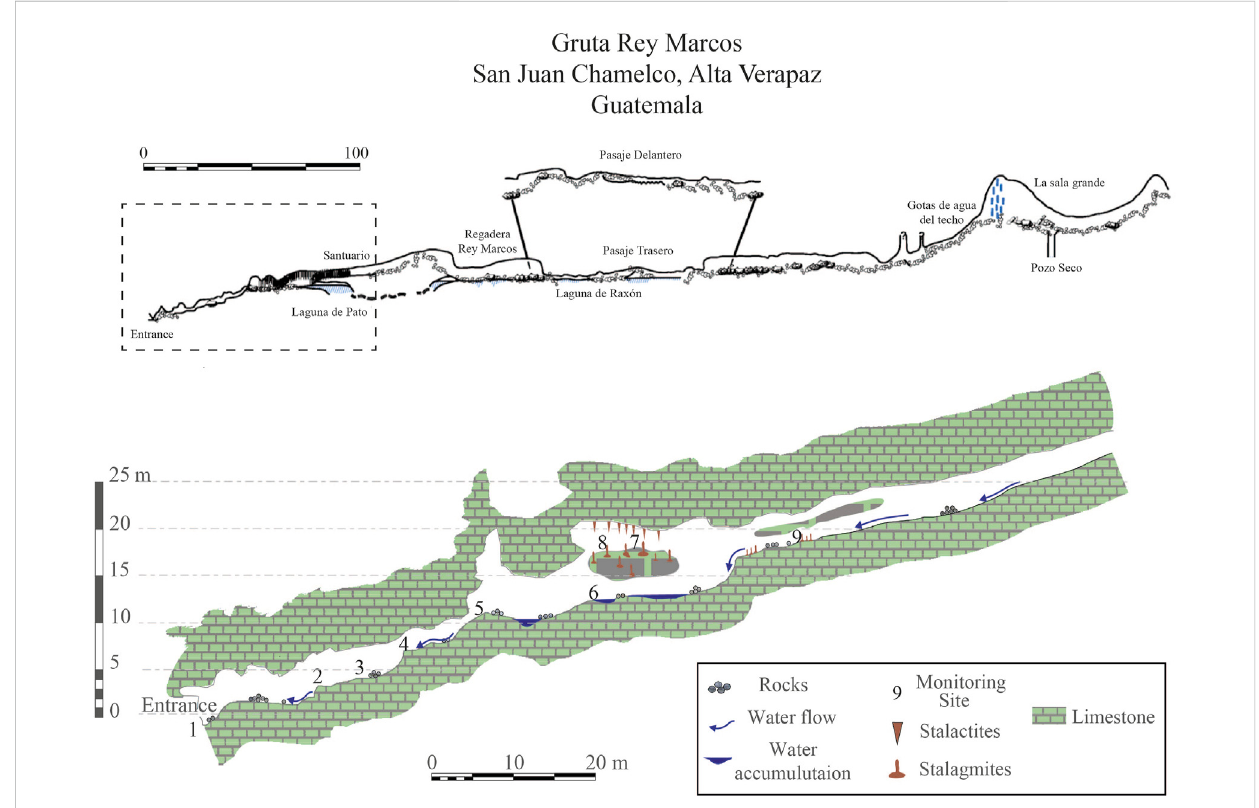
FIGURE 2 Top:TopographicmapofGrutadelReyMarcosoriginallydrawnusingcompassandmeasuringtape.Bottom:High-resolutionmapofthe fi rst100 m drawn using a laser of the cave indicating the different points monitored during this study. Points 8 and 9 are DS1 and DS2, respectively, in the text. Note that vertical and horizontal scales